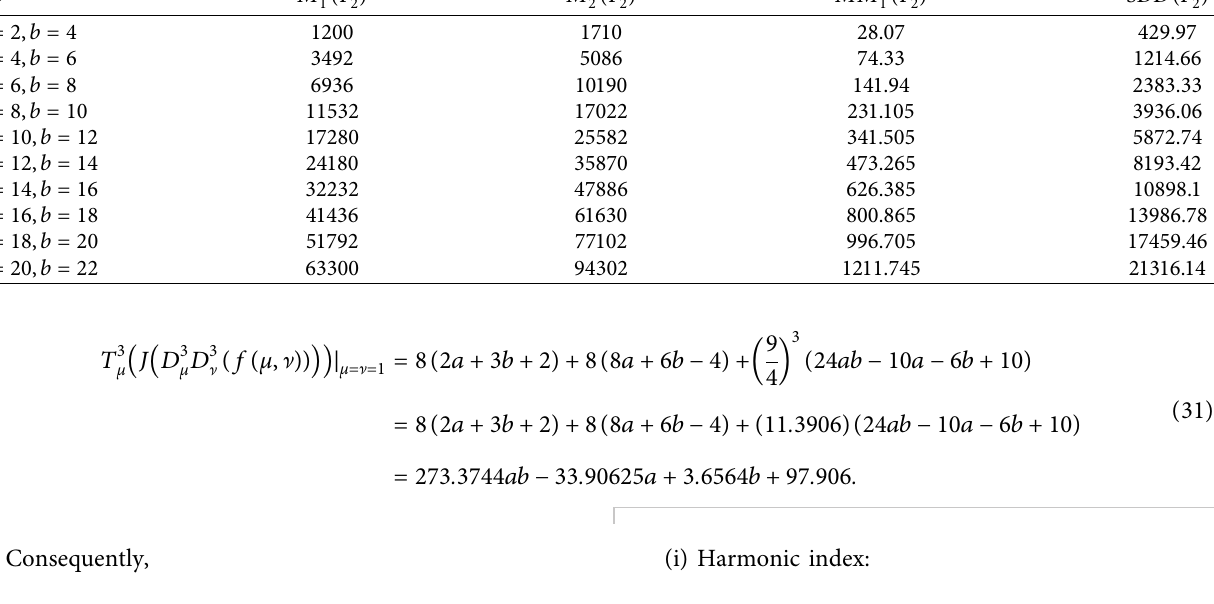
) of VC 1 ( Γ ) , and SDD ( Γ 1 2